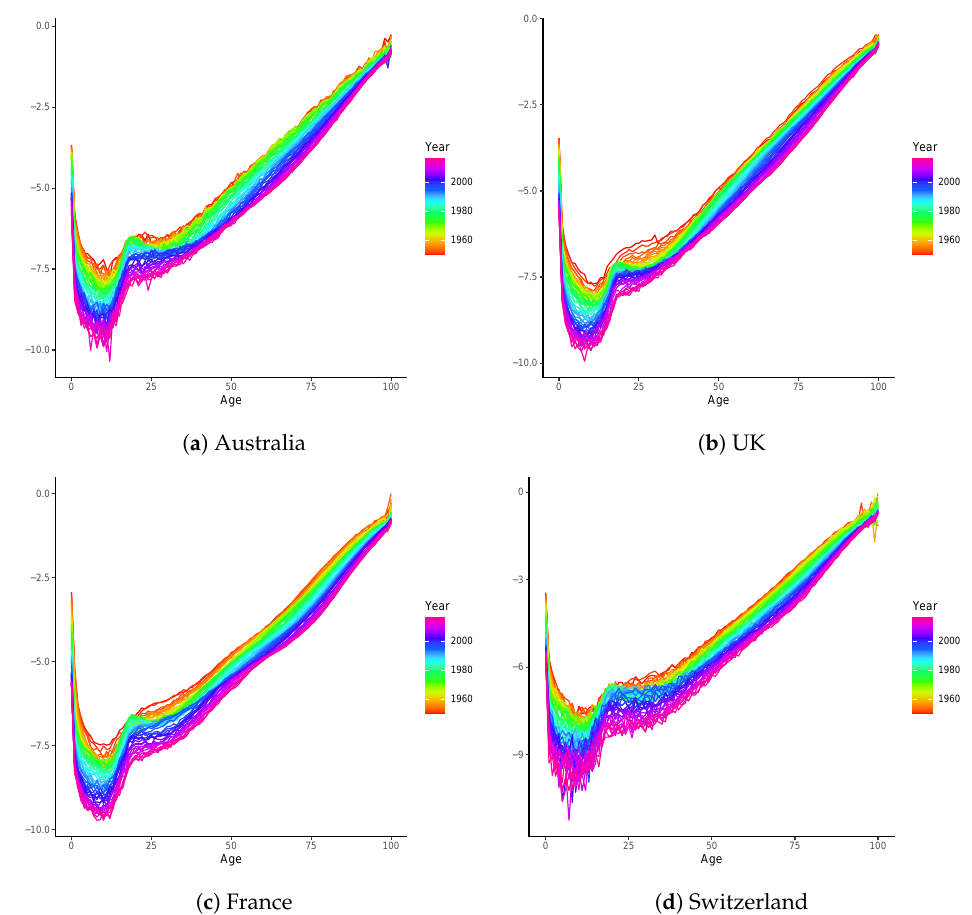
Figure 1. Logged central mortality rates of Australia, the UK, France, and Switzerland. The datasets include both males and females and span the period of